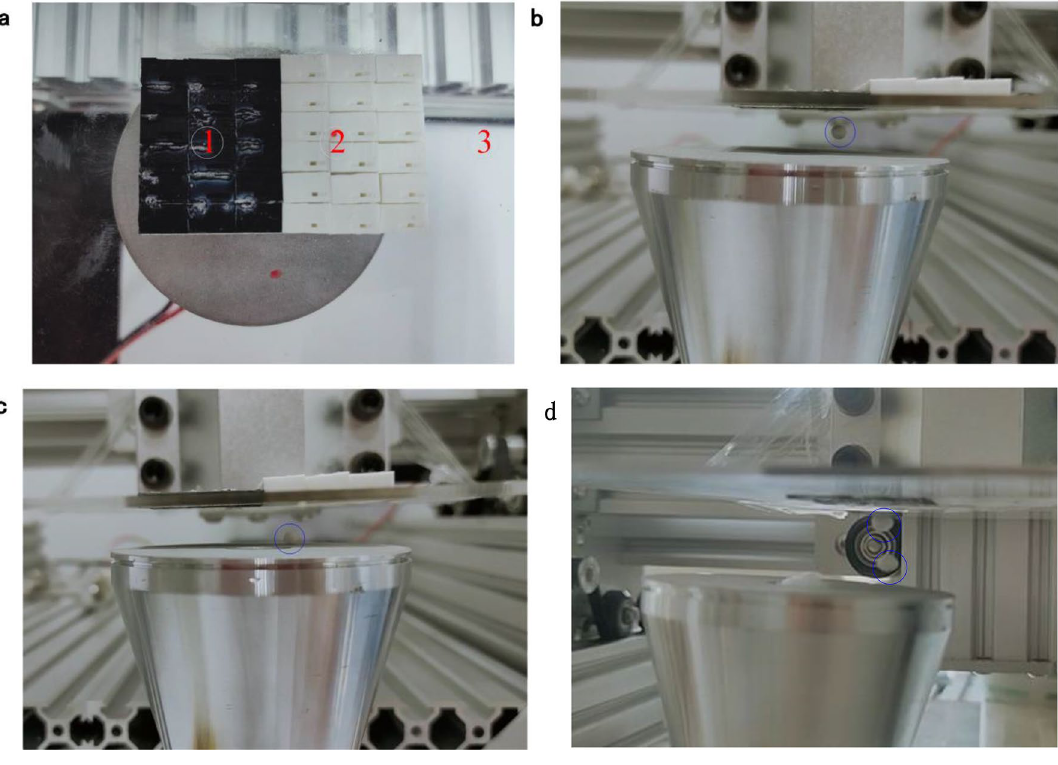
Figure 12. Acoustic levitation. ( a ) Acoustic levitation testing platform ( b ) Acoustic levitation in low pass domain ( c ) Acoustic levitation in high pass domain. ( d ) Acoustic levitation of two pellets in low pass domain.